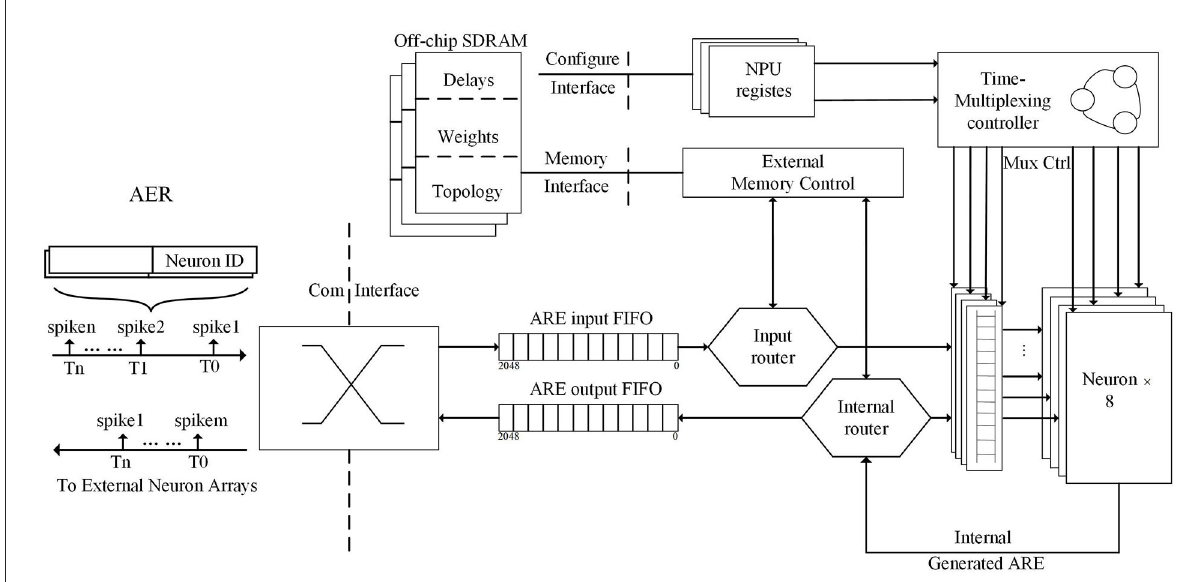
FIGURE3 Overall microarchitecture of the Darwin Neural Processing Unit (NPU) and the process of processing AER packages and outputting them.